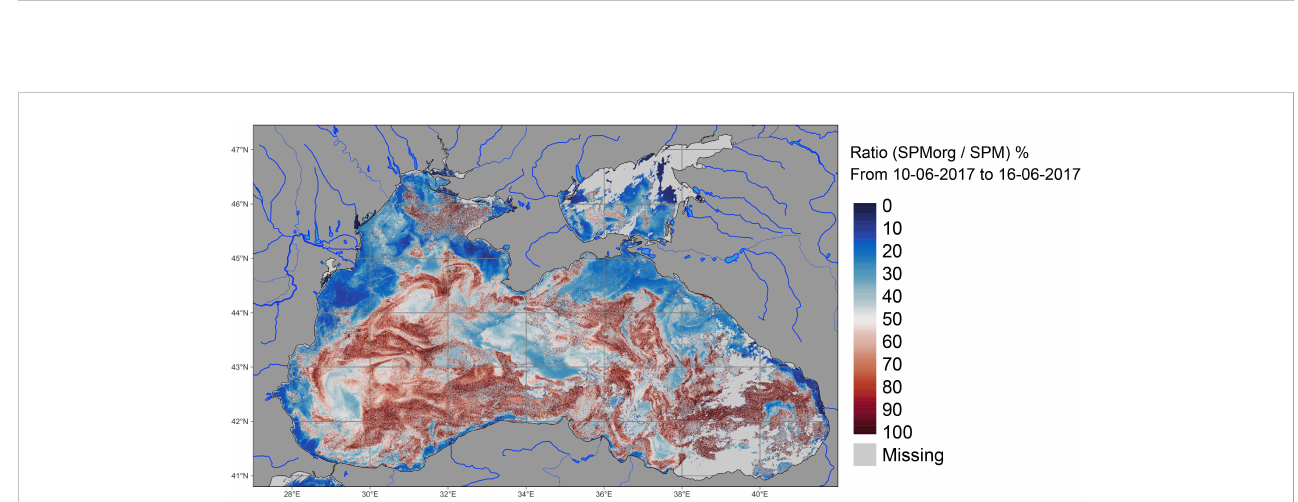
FIGURE 10 Map of the organic fraction (in %) of the SPM estimated during the coccolithophorid in June 2017 (weekly composite: 10-16 June 2017). This fraction has been computed using the approach described in Babin et al. (2003) (see their equations 1 and 2) using the estimated Chl-a as a proxy of the organic